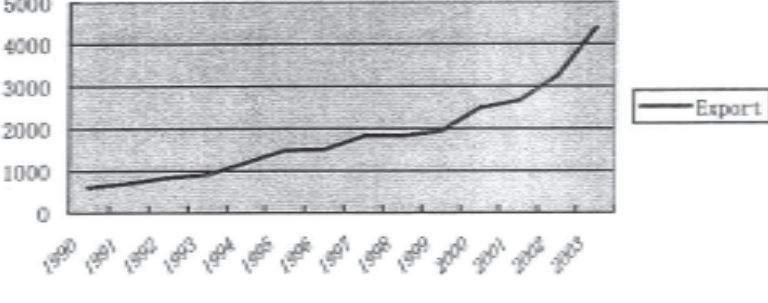
Source: www.mofcom.gov.cn